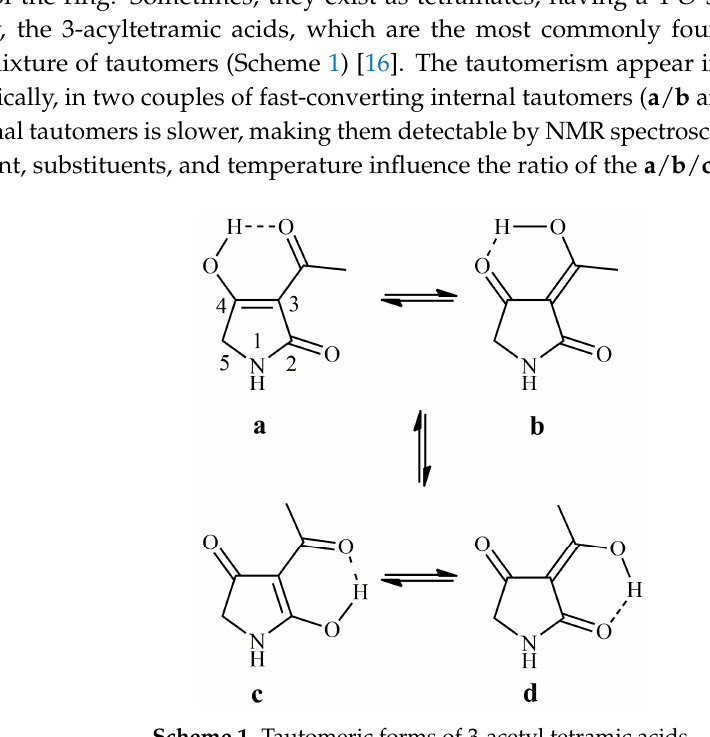
Scheme 1. Tautomeric forms of 3 ‐ acetyl tetramic acids.